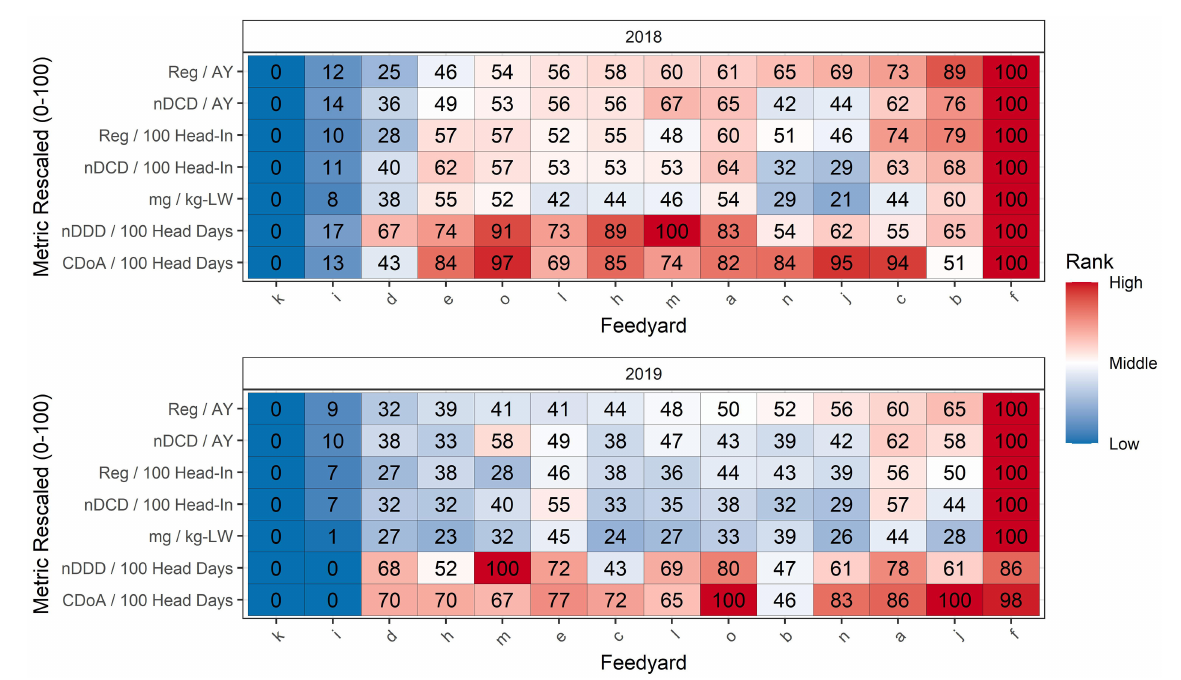
compared to nDCD/AY in 2018 there was still one feedyard different in the bottom 4 rankings and 2 feedyards different in the highest 4 rankings. Similarly, for CDoA/100 head days as compared to nDDD/100 head days, 2 feedyards